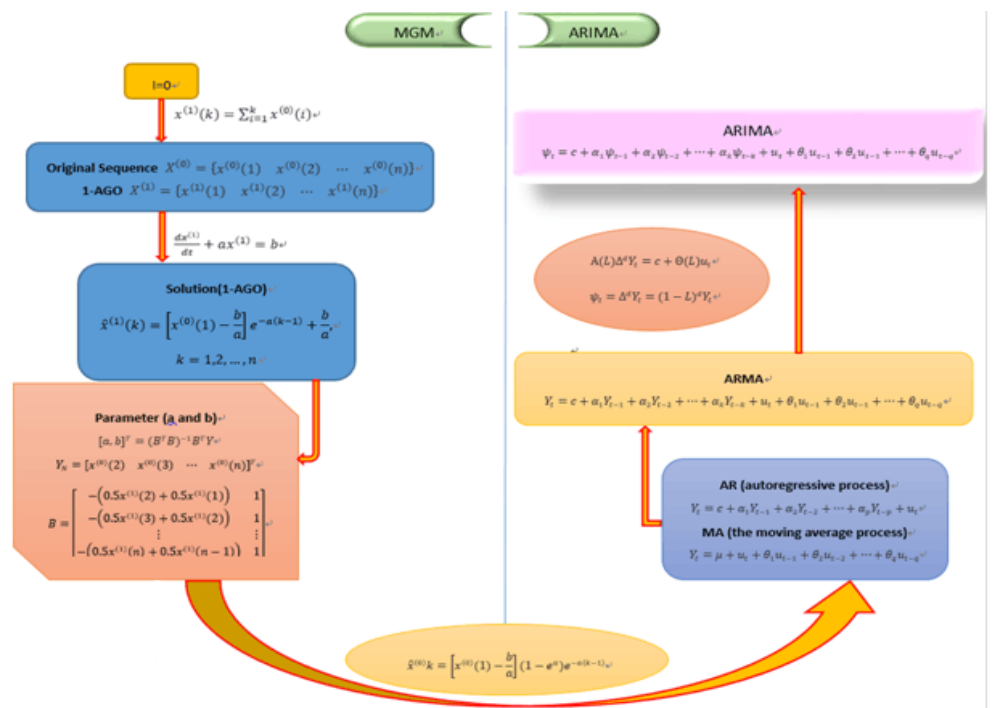
Figure 2. Method flow chart of MGM-ARIMA model.